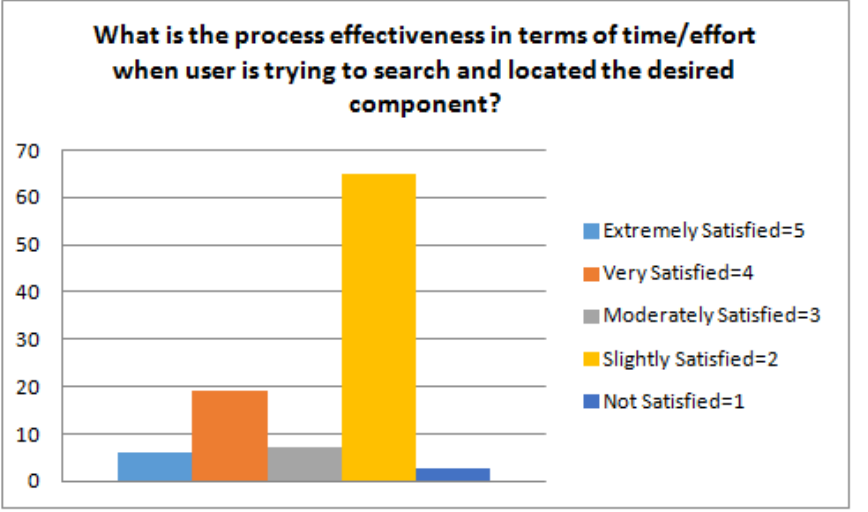
Figure 8. Component retrieval process